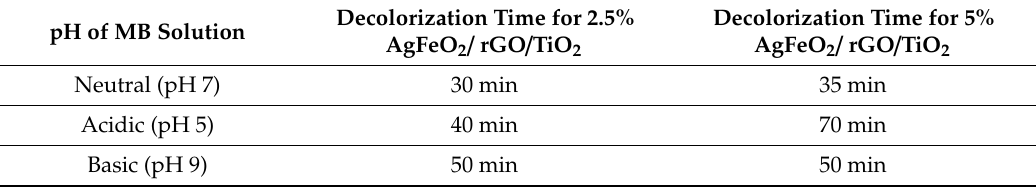
Table 1. Decolorization time for MB at various pH of Dye